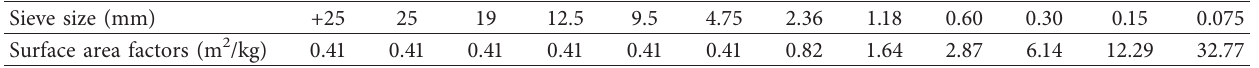
Table 2: Asphalt Institute (AI) surface area factors.